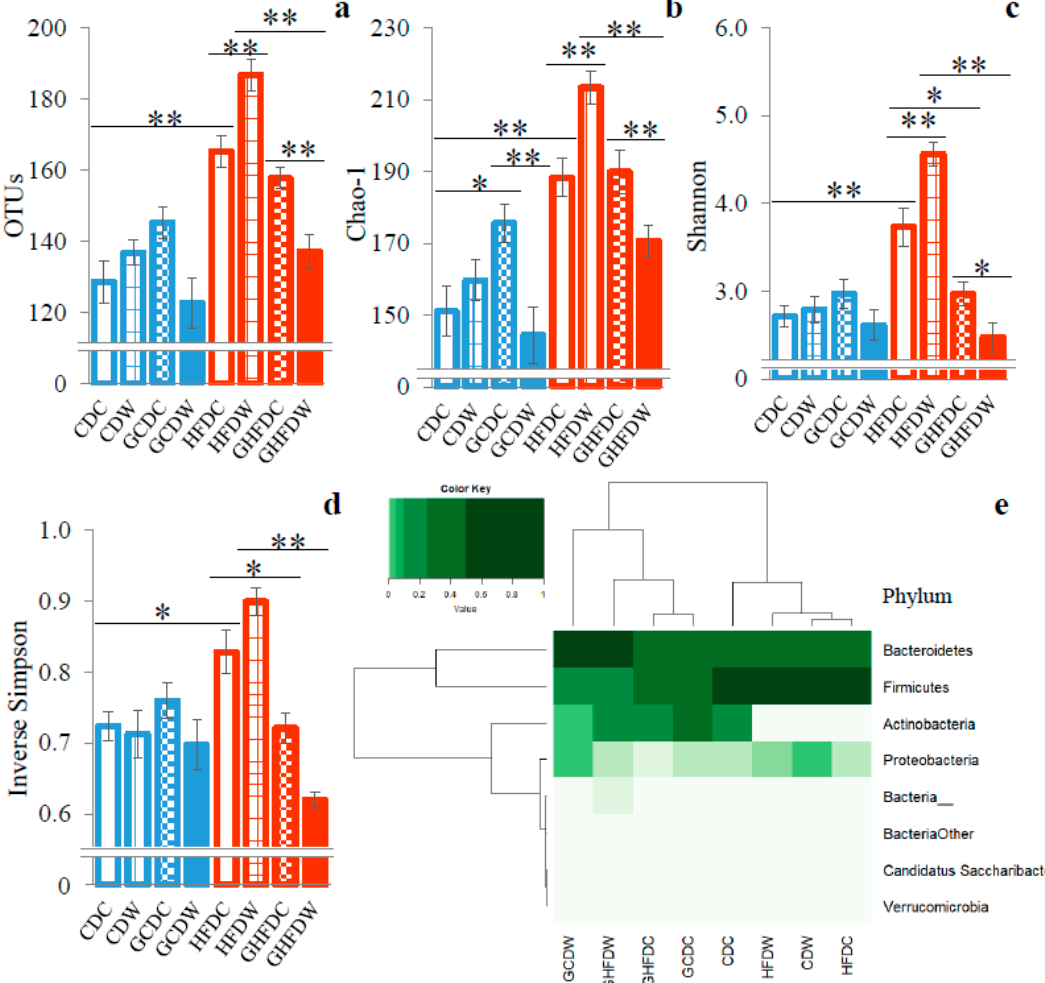
Figure 4. The supplemental effect of wheel running on bacterial diversities in the gut microbiota in PHGG intake mice under CD and HFD feeding. The OTUs ( a ), Chao-1 ( b ), Shannon ( c ), and inverse Simpson ( d ) indexes are shown as the α -diversities. The heatmap showed gut microbiota distribution at phyla level of taxon, and the dendrogram showed the clustering of phyla as the β -diversity ( e ). The values of α -diversities were expressed as the mean ± S.E.M. * p < 0.05 and ** p < 0.01.